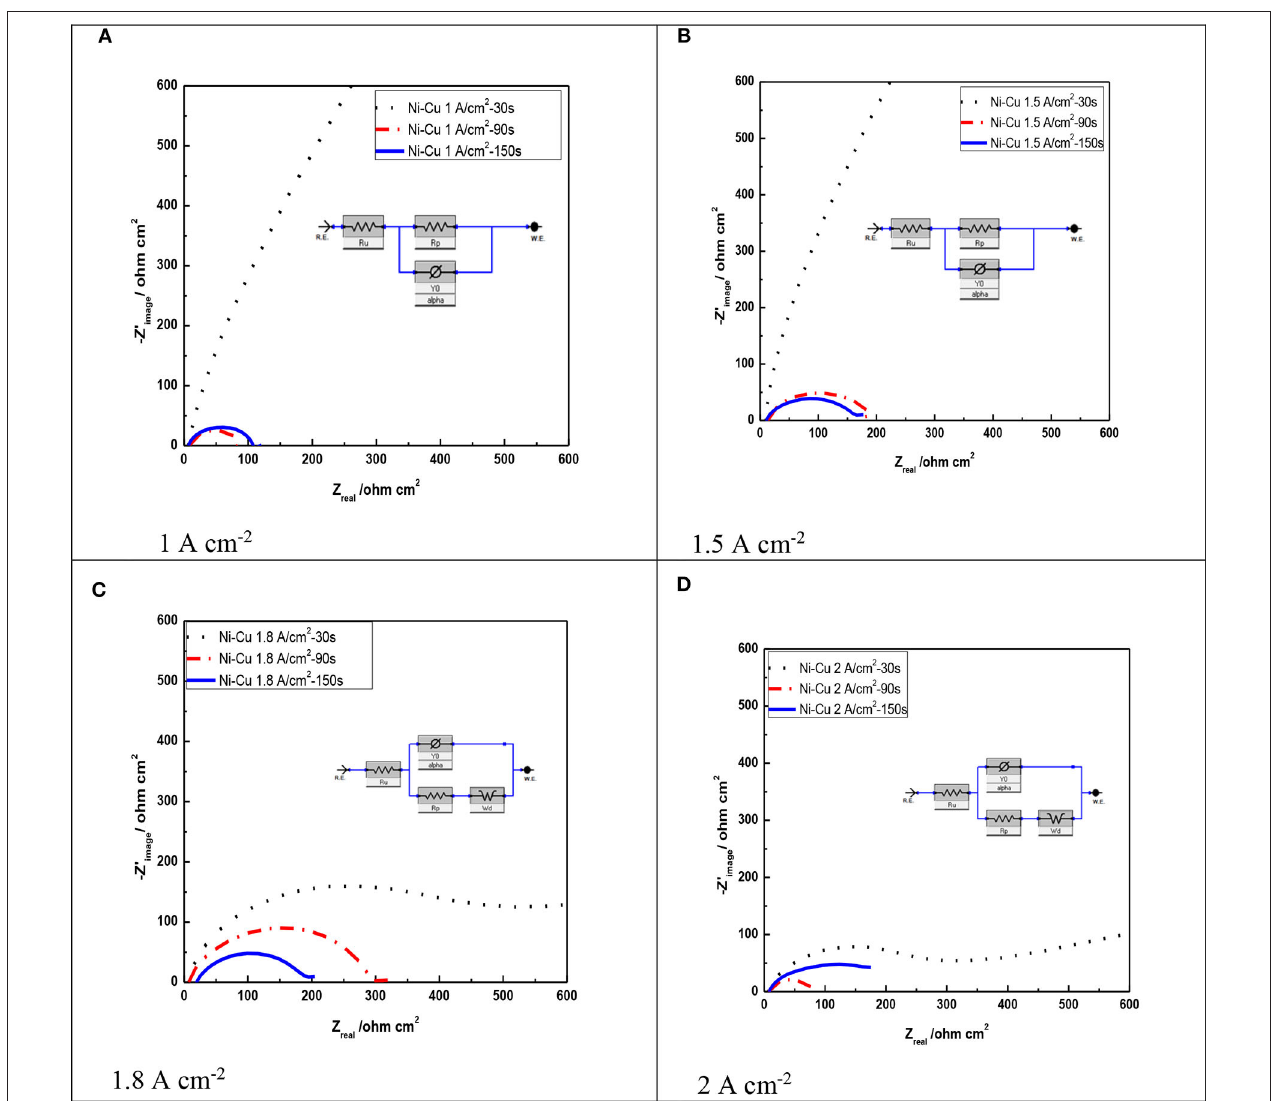
FIGURE 7 | Nyquist plots of Ni–Cu foams tested in acidic 1M KOH solution as a function of current density as well as electrodeposition time at 25 ◦ C. (A) 1A cm − 2 , (B) 1.5A cm − 2 , (C) 1.8A cm − 2 , (D) 2A cm − 2